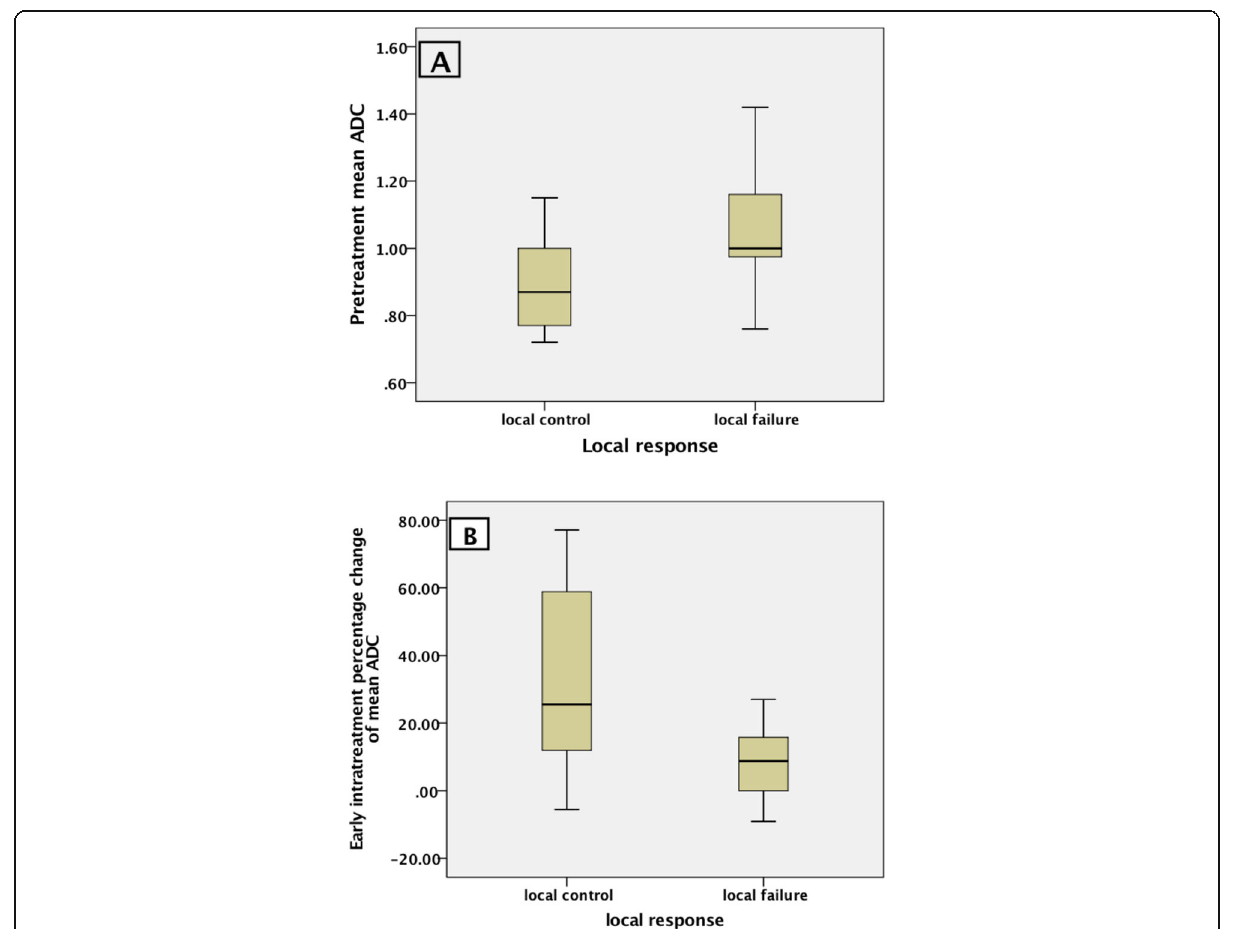
Fig. 1 Box-Whisker plots comparing the pretreatment mean ADC in a and early intratreatment percentage change of mean ADC in b between local control and local failure patient groups. Local failure patient group shows significantly higher ADC pre and lower Δ